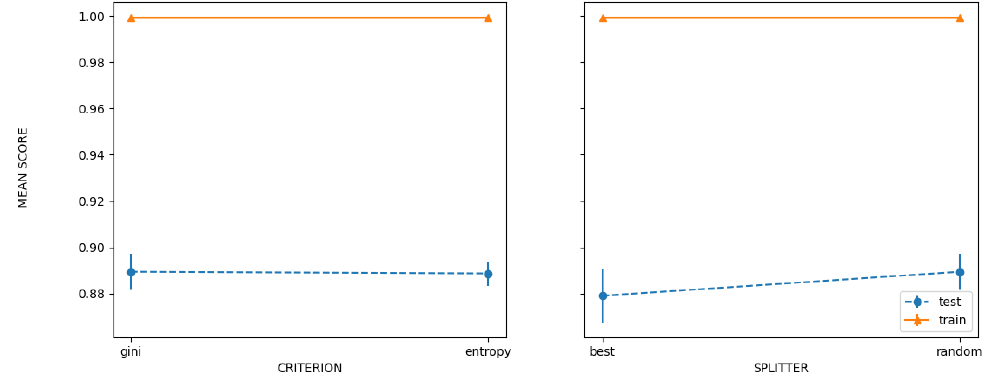
Figure 12. Score per parameter for Decision Tree